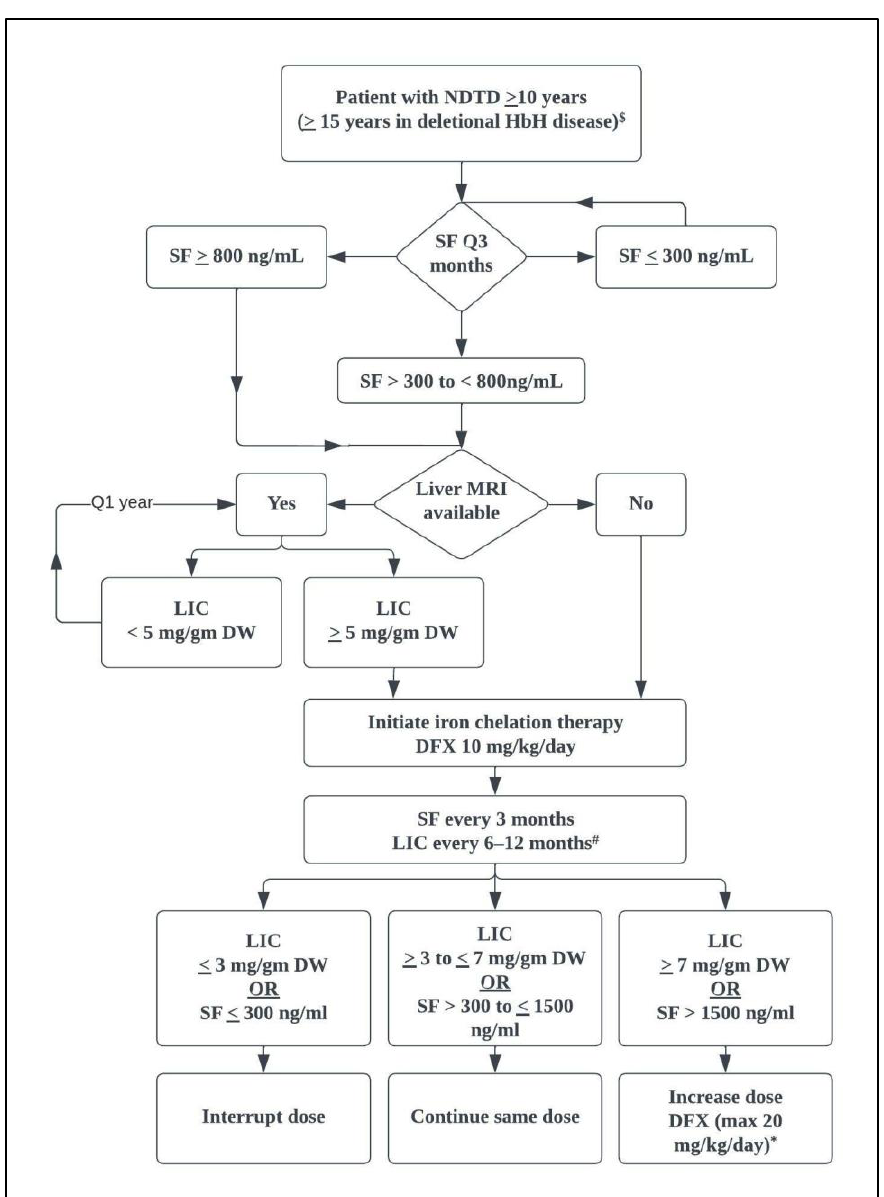
Figure 3. Algorithm for iron chelation in NTDT [16,65,72]. LIC: liver iron concentration; NTDT: non- transfusion dependent thalassemia; SF: serum ferritin; DW: dry weight; DFX: deferasirox; MRI: